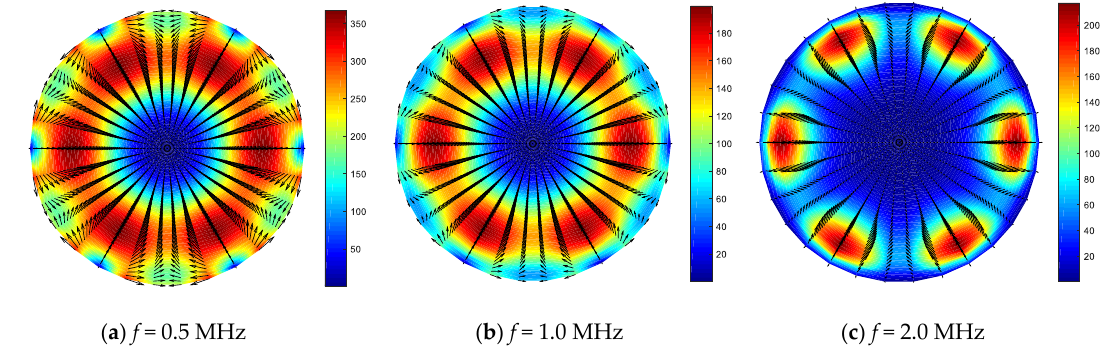
Figure 10. F d (3,1) Poynting vector at each frequency.